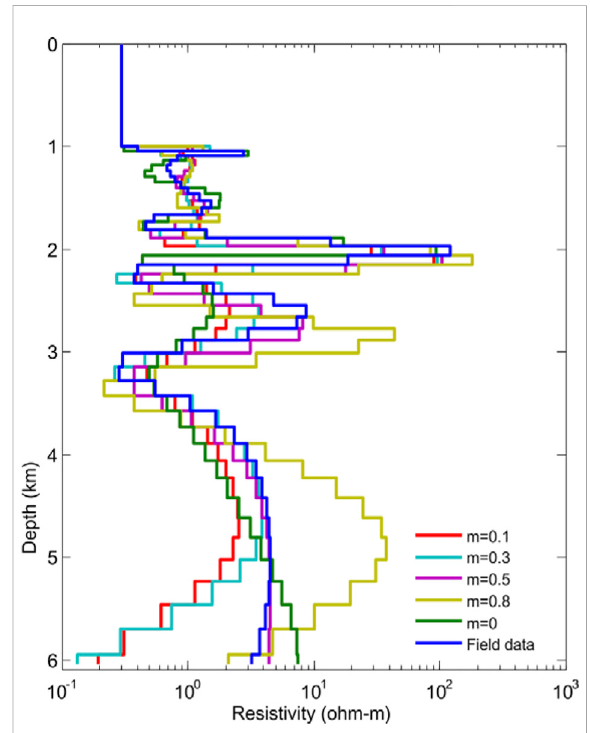
FIGURE 16 InversionofresistivityfromCSEM fi elddata(blue)withvarious polarizability m = 0 (pure electromagnetic fi eld) (green), 0.1 (red), 0.3 (light blue), 0.5 (purple), and 0.8 (yellow),